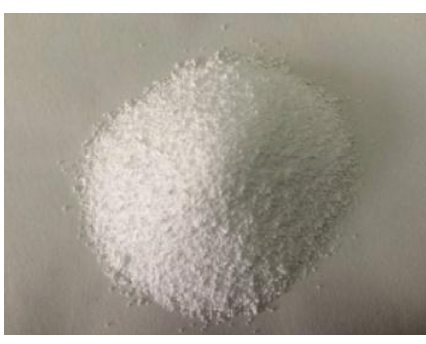
Figure 2: Photo of